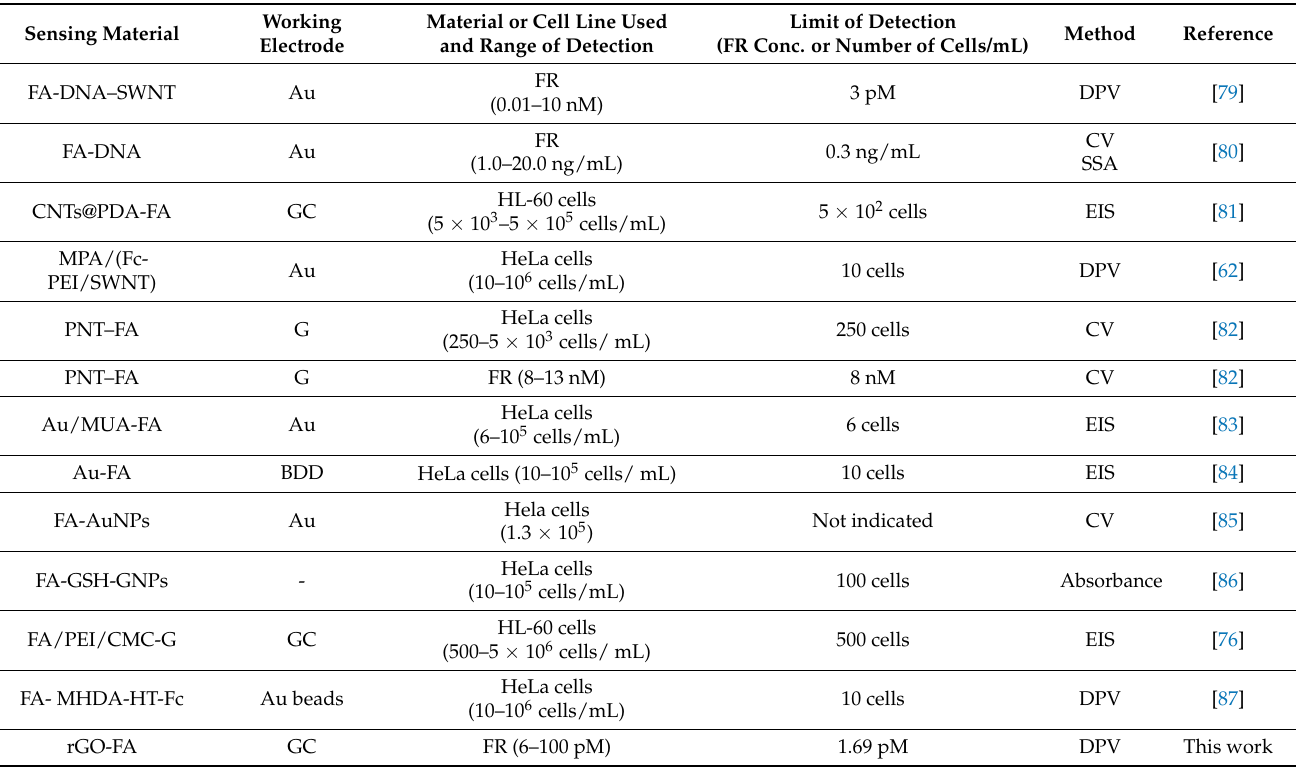
Figure 8. DPV analysis of rGO-FA with the addition of FR at the predetermined intervals at a scan rate of 50 mV s − 1 . Table 2. FA–FR-based sensing studies for cancer cell